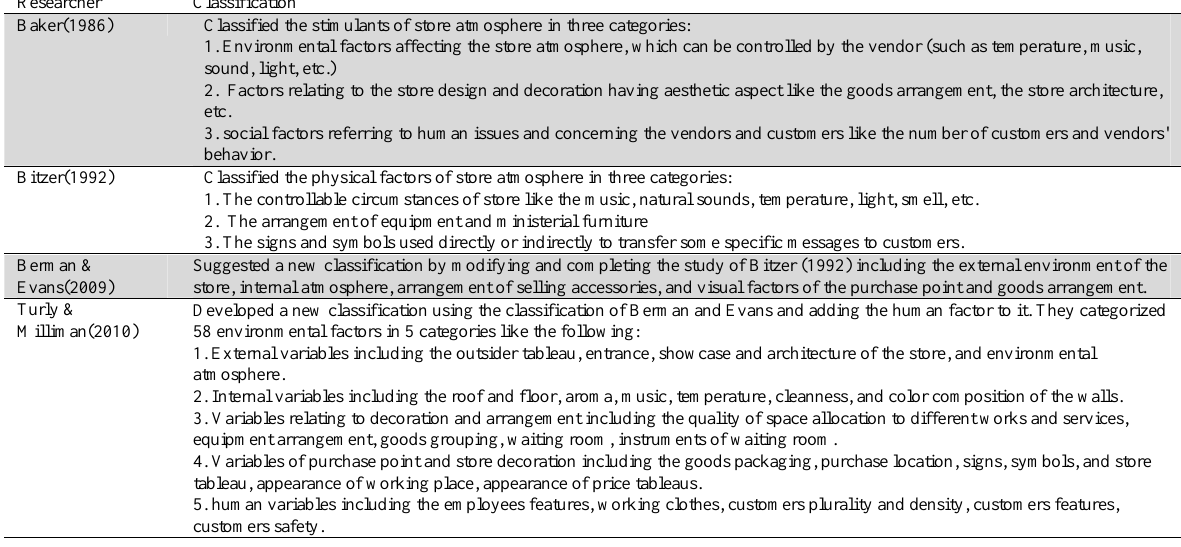
Classification of the variables existing in the store